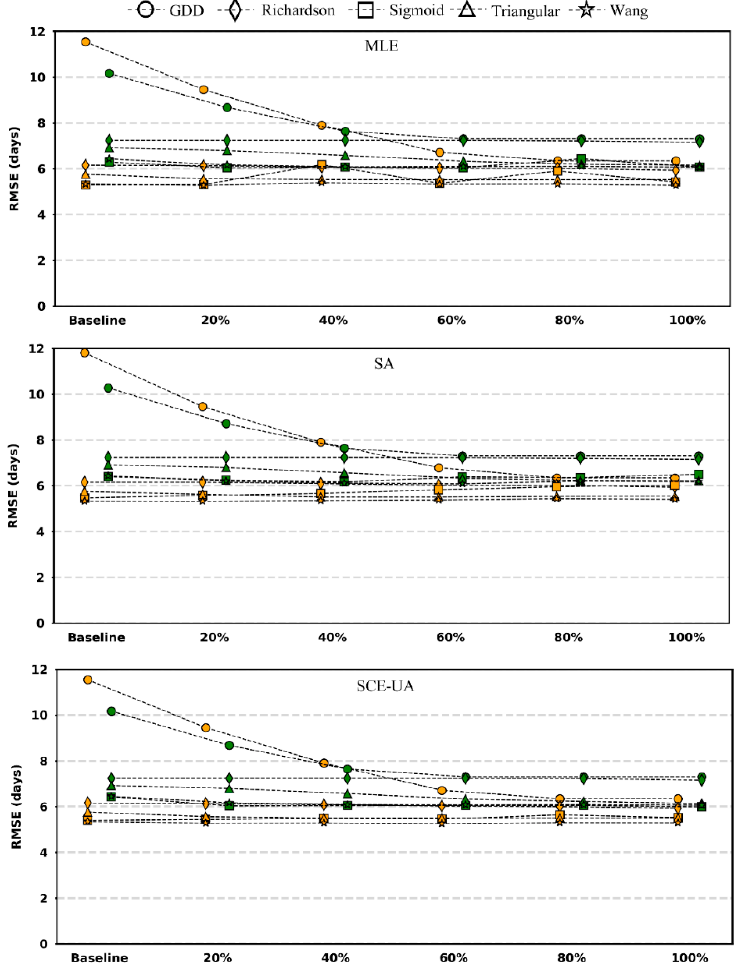
Figure 3. Root Mean Squared Error (RMSE) computed between five phenology model simulations of the optimum parameters obtained from three global optimization algorithms (MLE: Maximum Likelihood Estimation; SA: Simulated Annealing; SCE-UA: Shuffled Complex Evolution) and the corresponding observed flowering data of two dominant Portuguese grapevine varieties (Touriga Franca: filled orange symbols; Touriga Nacional: filled green symbols). The orange and green symbols are slightly displaced in the x -axis to avoid the symbol overlap. The analysis is carried out by gradually expanding the initially defined range of distribution for each model parameter (baseline settings) by up to 100% (the percentage in the x -axis corresponds to each expanded percentage test category). An expanded range of 20–100% corresponds to 120–200%, relative to the initial baseline range. The observed phenology data correspond to blended multi-vineyard observations within the Douro region in the period of 2014–2021.